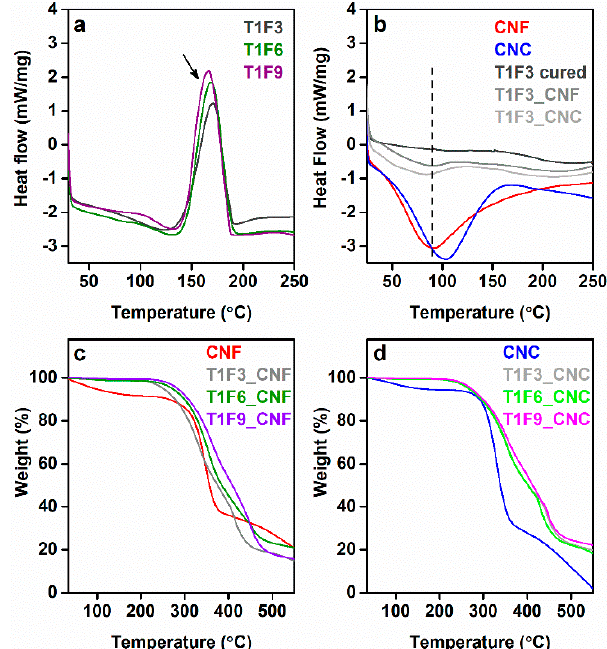
Figure 3. Di ff erential scanning calorimetry (DSC) plots (first heat scans). ( a ) Curing of resins (black arrow indicates the curing reaction temperature at ~165 ◦ C). ( b ) CNF, CNC, cured T1F3 resin, CNF and CNC films impregnated with T1F3 resin (black dashed line indicates the endothermic transitions in CNF and CNC at 30–100 ◦ C). DSC plots of cured T1F6, T1F9 resins, and their composites are shown in